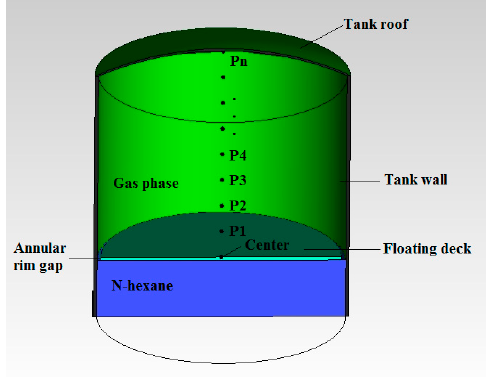
Figure 14. Location of monitored points.